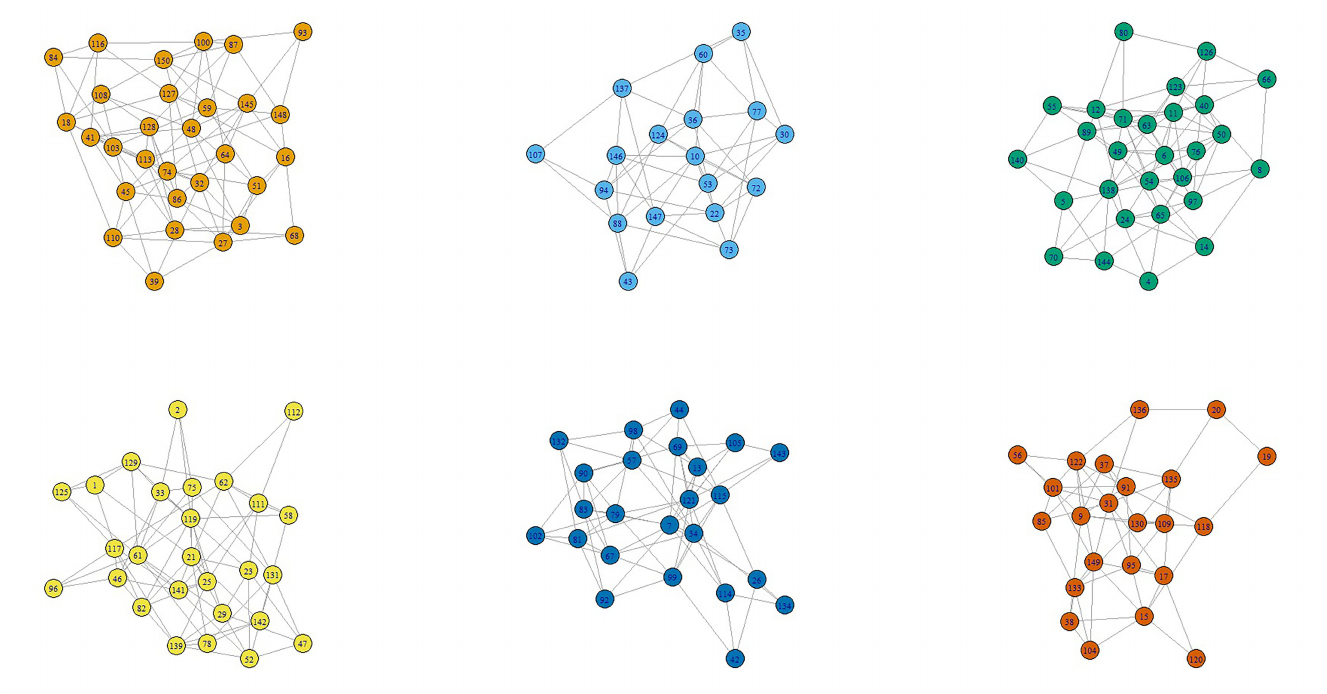
Figure 11. Subgraphs or subnetworks of the first and second networks.